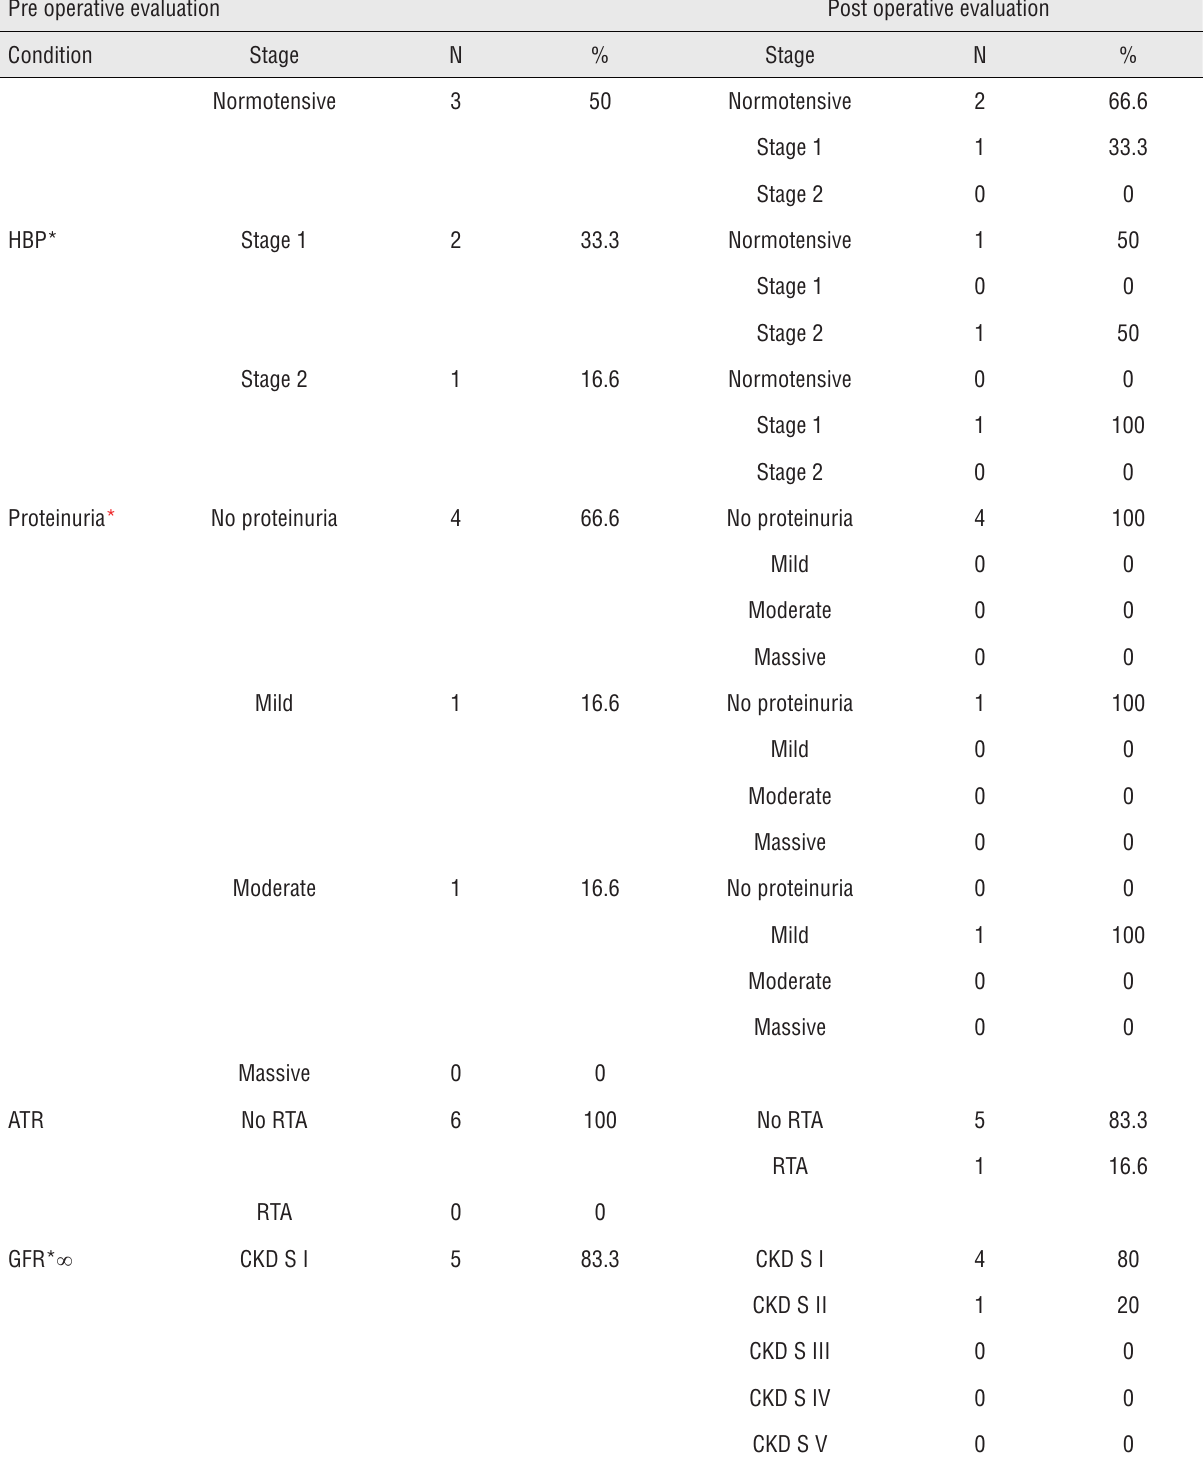
Table 2 - Pre and post- operative evaluation of patients who underwent unilateral nephrectomy for oncological condition. Pre operative evaluation Post operative